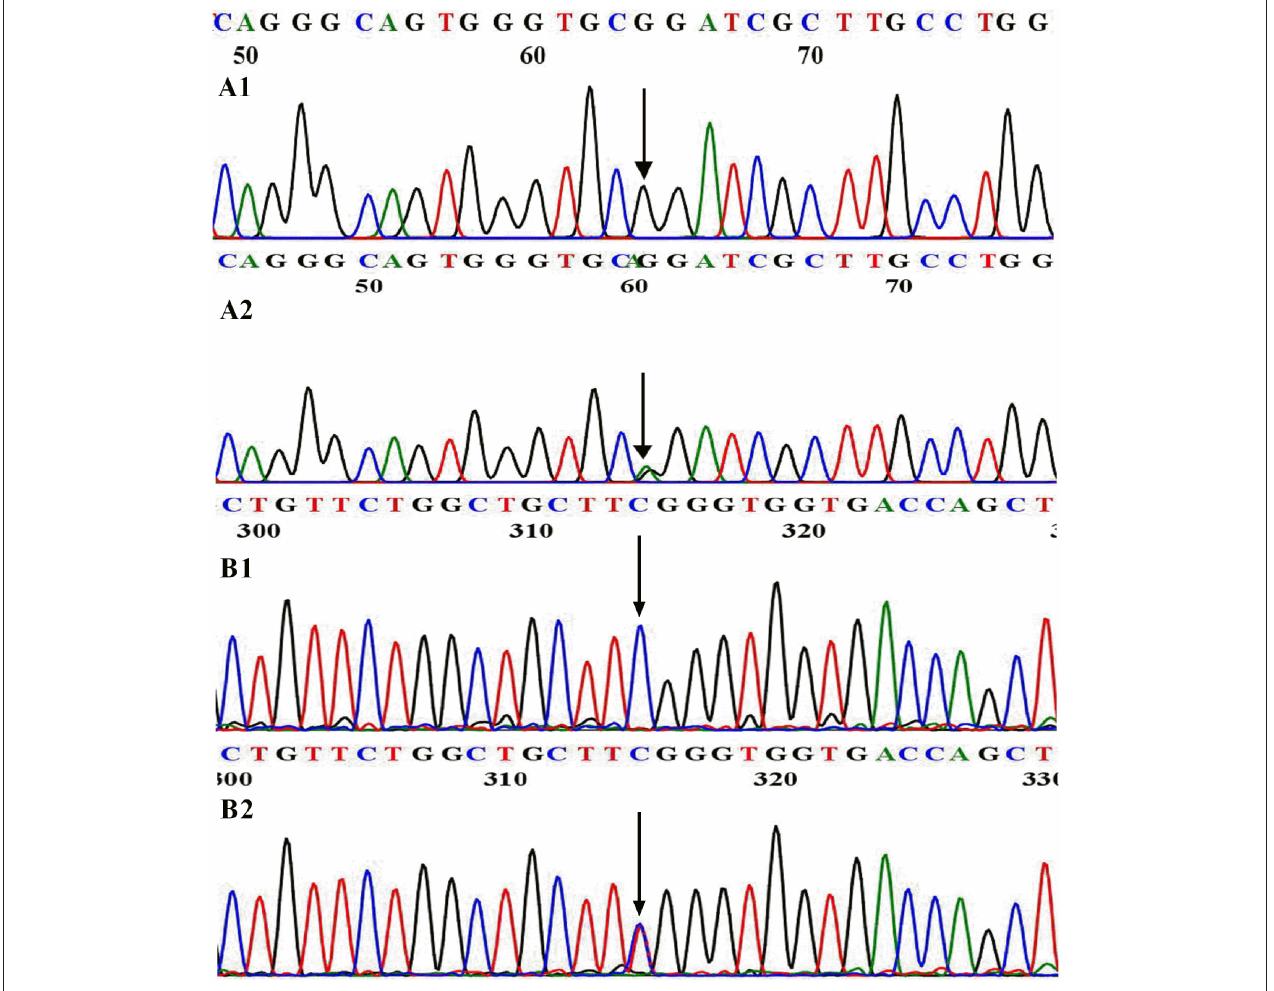
FIGURE 1 | WT and mutational sequences of exon 31 in DUOX1 (A) and exon 6 in DUOXA1 (B). (A1) Arrowhead indicates homozygous G at nucleotide 3920 in normal individuals; (A2) Arrowhead indicates the heterozygous A and G at nucleotide 3920 in patient 1. (B1) Arrowhead indicates homozygous C at nucleotide 166 in normal individuals; (B2) Arrowhead indicates the heterozygous C and T at nucleotide 166 in patient 2.